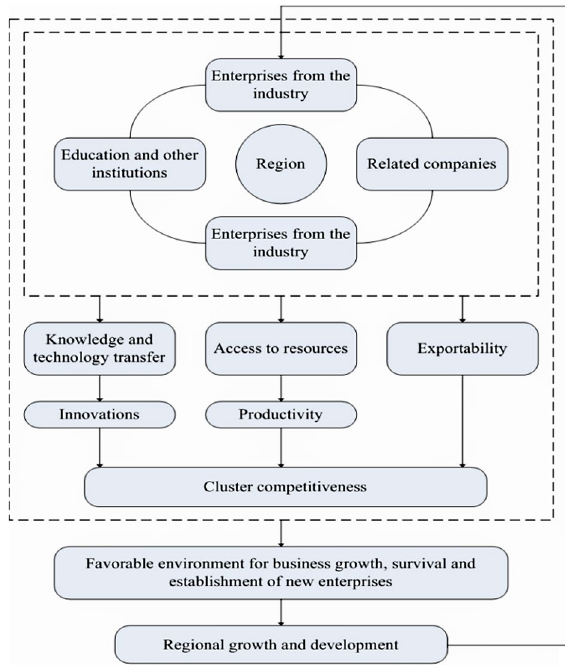
Fig. 1. Regional Cluster Effect on Regional Growth and Development (Garanti, Zvirbule-Berzina